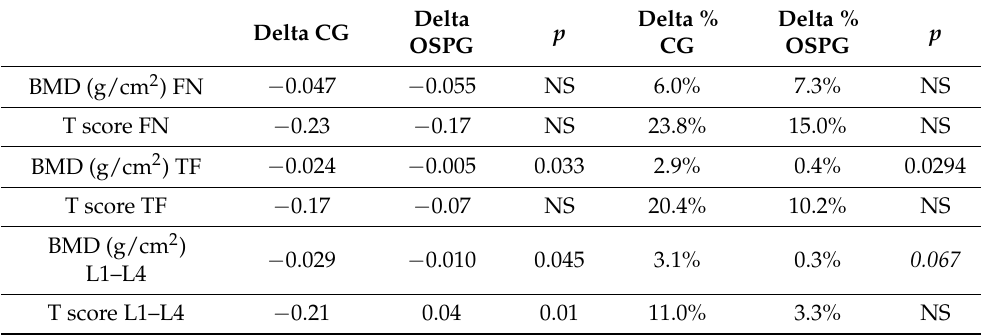
Table 2. Differences between absolute and percent delta of BMD and T-score at FN, TF, and L1–L4. p in italics indicates a tendency towards statistical significance.